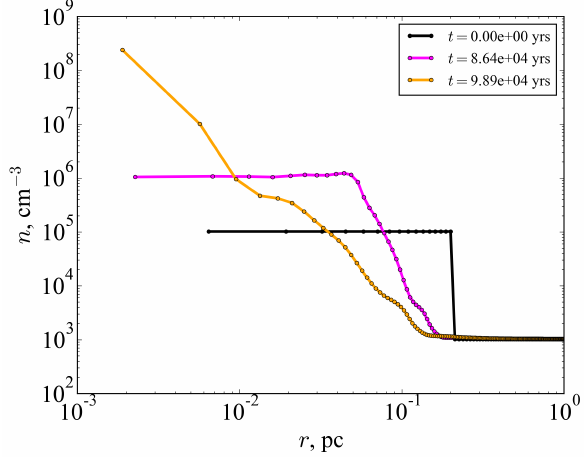
Figure 1. The n ( r , z = 0) dependences for the isothermal cylinder without magnetic field at t = 0 (black), t = 8.64 × 10 4 yrs (magenta) and t = 9.89 × 10 4 yrs (orange) after the beginning of the